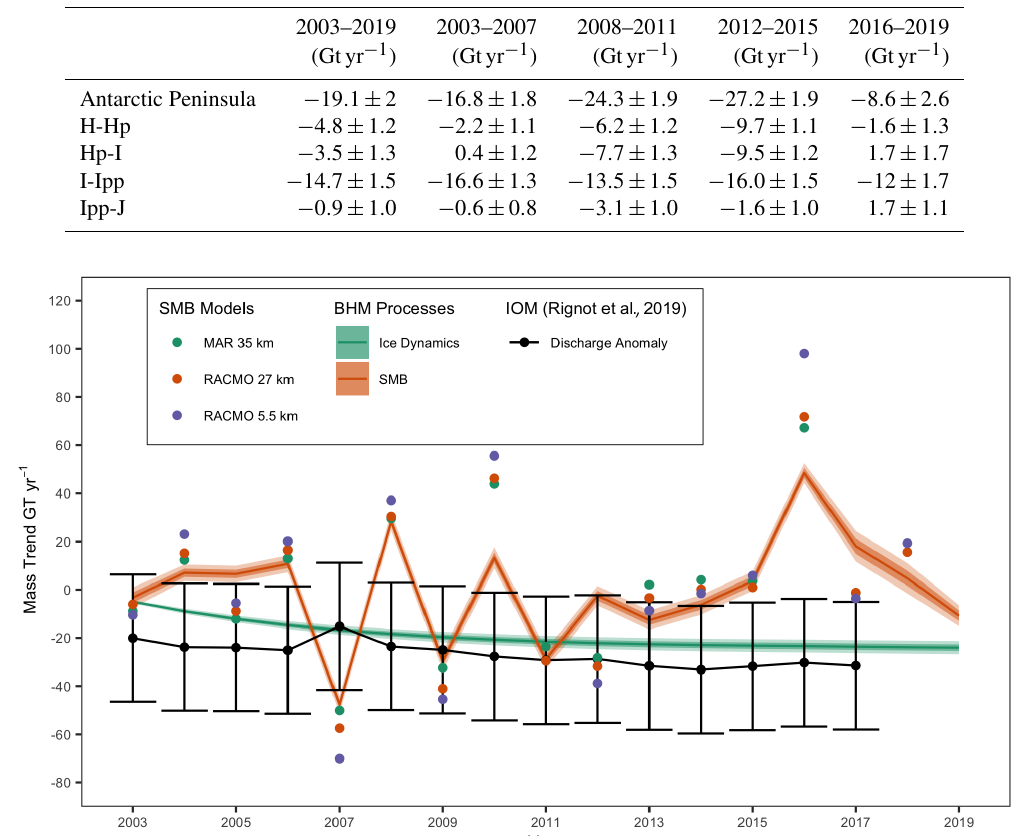
Figure 3. SMB and ice dynamic mass trends for the AP region (line plots, with shaded ribbons representing 1 σ and 2 σ uncertainties). Scatter points represent RCM mass anomalies with respect to a 1979–2002 baseline (Agosta et al., 2019; van Wessem et al., 2016, 2018), and the black line represents the annual ice discharge anomaly with respect to a 1979–2002 baseline value, with the 1 σ uncertainty on the discharge represented by the crossbars as stated in Rignot et al. (2019). See Sect. S1 for methodologies used for dataset